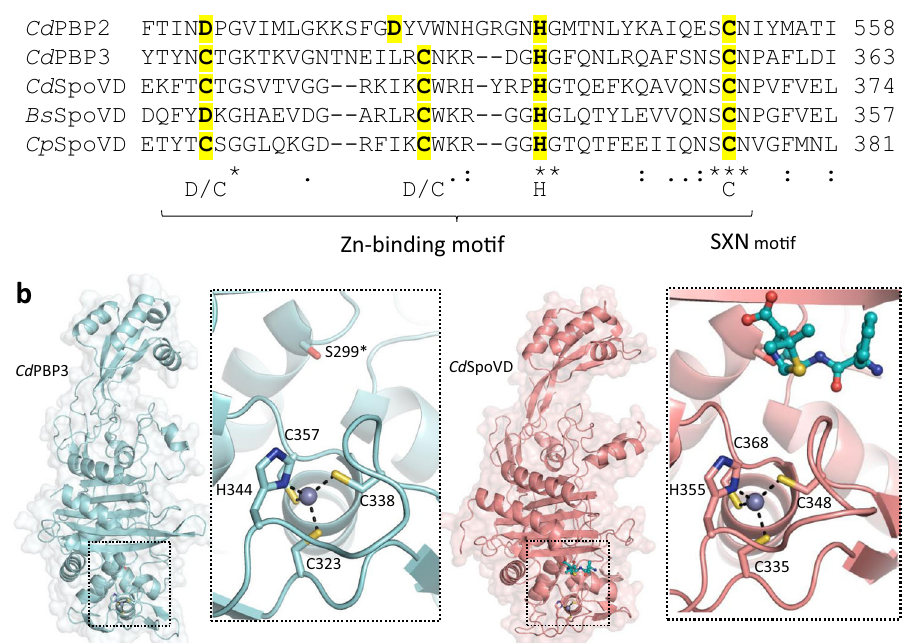
Fig.4| C.dif fi cile andotherspore-formingFirmicutesencodeauniquefamilyof Zn 2+ -binding PBPs. a Multiple sequence alignment uncovers a conserved Zn 2+ - coordinating tetrad in C. dif fi cile PBP2, PBP3, SpoVD, and other spore-forming